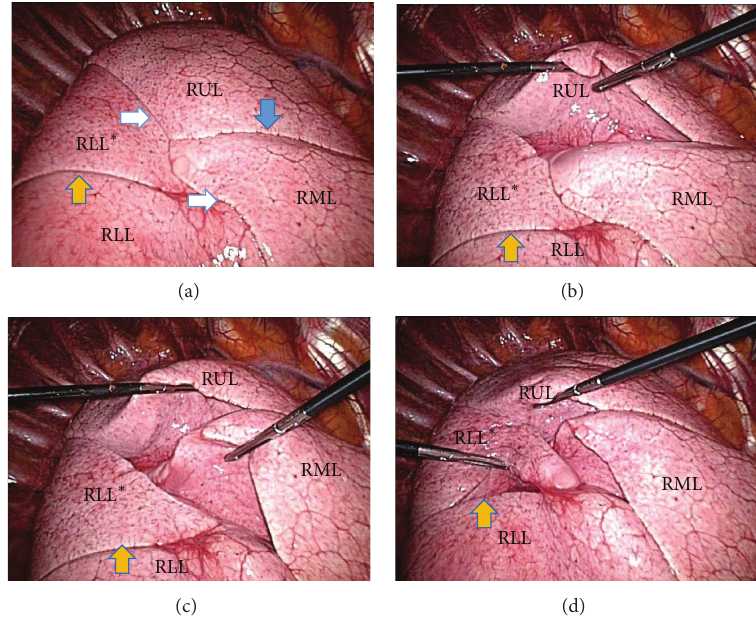
Figure 1: Perioperative pictures during VATS. All photographs were taken from the camera port distally with the patient lying on his left side and the arm in 90 degrees so the respective sides of these photographs concur with apical, ventral, distal, and dorsal positions, respectively. On the ventral side, the right internal mammary artery and vein running near the sternum can be seen. Pictures (a) to (d) display the different fissures as shown with long shaft instruments. RUL: right upper lobe; RML: right middle lobe; RLL: basal segments of the right lower lobe; RLL ∗ : apical segment of the right lower lobe. Solid white arrows: horizontal fissure; blue arrow: oblique fissure; orange solid arrow: superior accessory fissure of the right lower lobe.